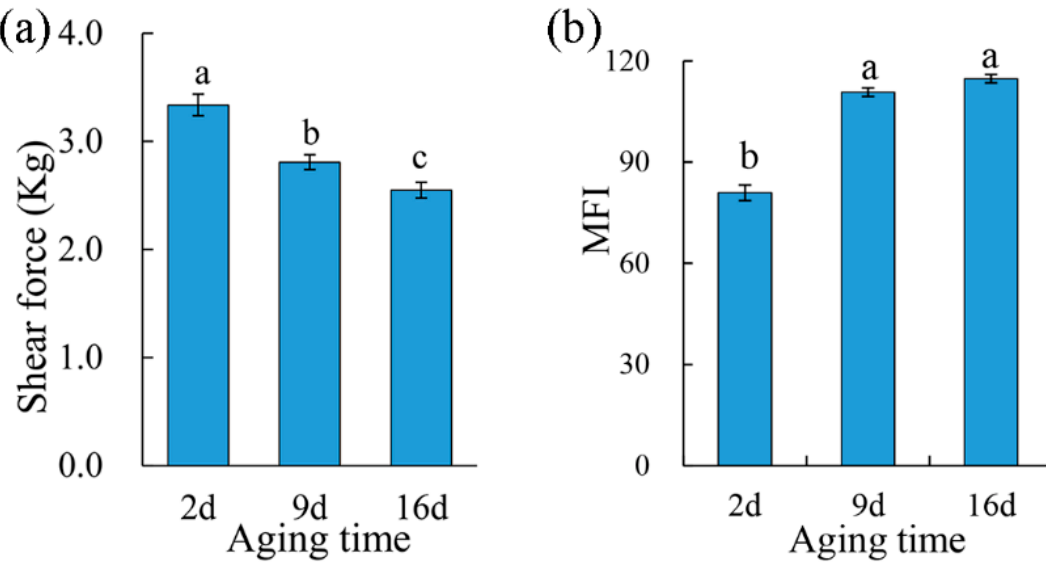
Figure 2. The effect of aging treatments on shear force ( a ) and the myofibril fragmentation index ( b ) of the pork meat. Results are expressed as the mean ± standard error. Means with different letters (a–c) are different ( p < 0.05).